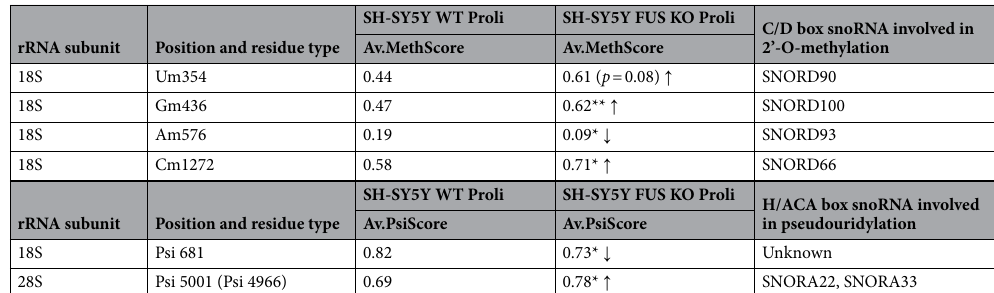
Table 2. 2’-O-methylation and pseudouridylation positions changed in 18S and 28S ribosomal RNAs in SH-SY5Y WT and FUS KO cell lines in proliferating (Proli) conditions. The MethScores and the PsiScores represent the average of three biological replicates and describe a fraction of molecules methylated and pseudouridylated at a given position, respectively. The old nomenclature is shown in brackets. Arrows depict the direction of modification changes in FUS KO cells relative to WT cells. P values were calculated using paired Student’s t -test, and the statistical significance is represented as fallows: * p ≤ 0.05; ** p ≤